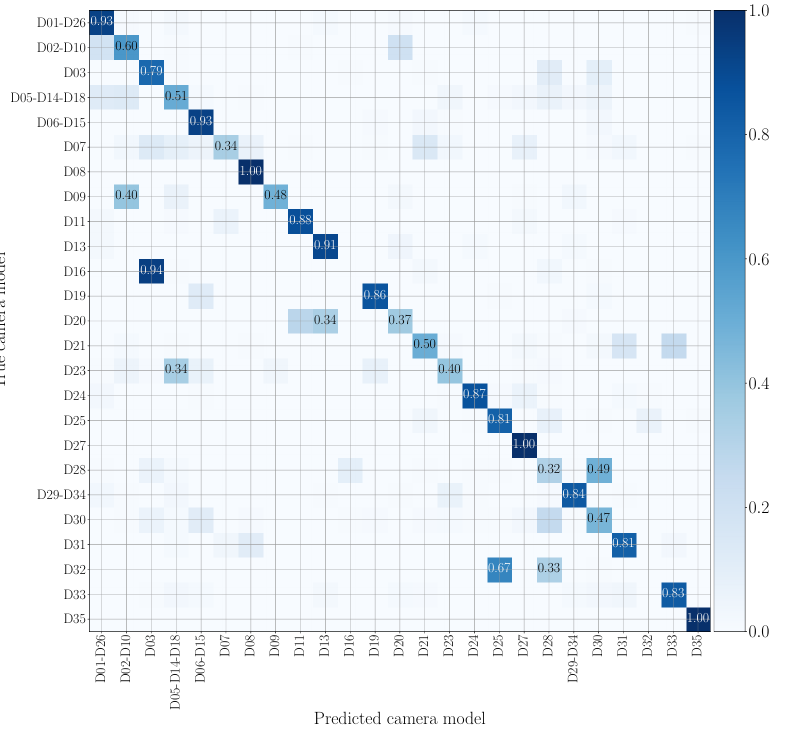
Figure 8. Confusion matrix achieved by mono-modal camera model identification exploiting audio patches only. We report results by training and testing on the native video set, and we only show the numbers which exceed 0.3. Device nomenclature is that of [44].